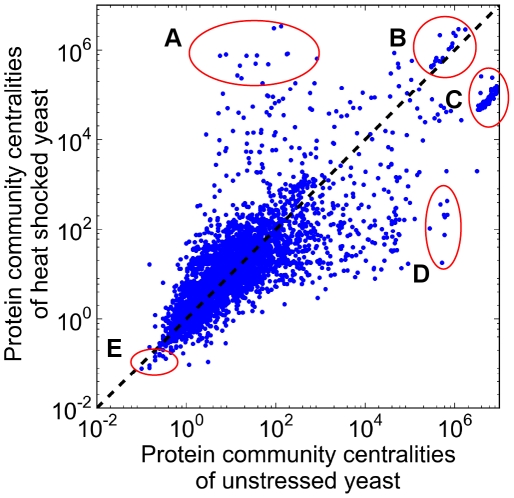
Yeast proteins with altered community centrality upon heat shock.Unstressed and heat shocked (15 min heat shock at 37°C) yeast BioGRID protein-protein interaction networks were created as described in the Materials and Methods section. Community centrality values of proteins were calculated by the NodeLand influence function method [8]. Each blue dot represents a yeast protein having its community centrality value in unstressed state plotted on the x axis, while the same value after heat shock plotted on the y axis. The 1∶1 correlation is represented by the black dashed line. Five groups of proteins with extreme behavior were labeled by red circles, and indicated by letters A through E: small→large community centrality (A), large community centrality in both conditions (B), extra large→slightly smaller community centrality (C), large→small community centrality (D), small community centrality in both conditions (E). Names and functions of proteins belonging to groups A through E are listed in Table S3 of Text S1.